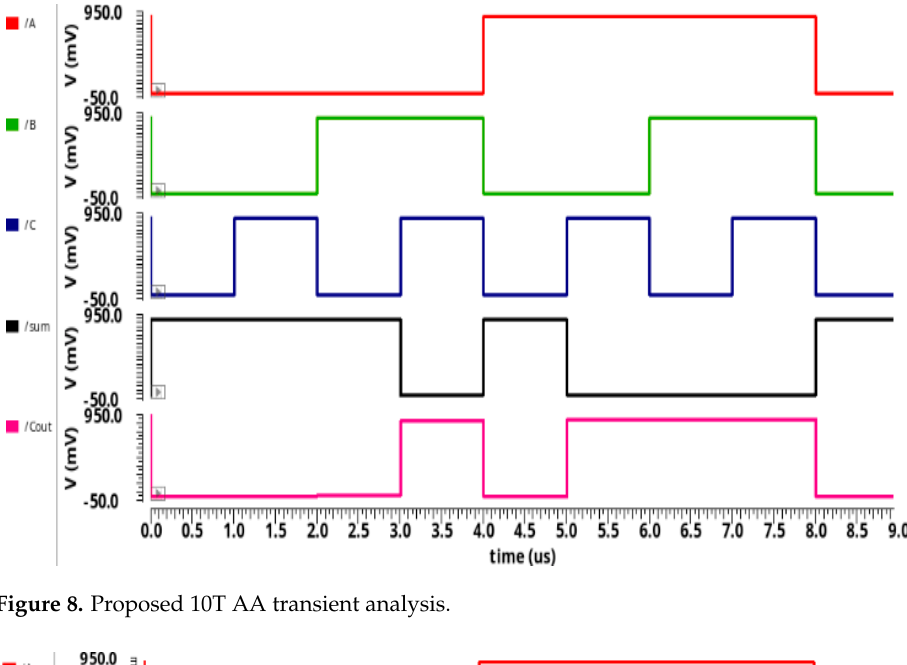
Figure 8. Proposed 10T AA transient analysis.